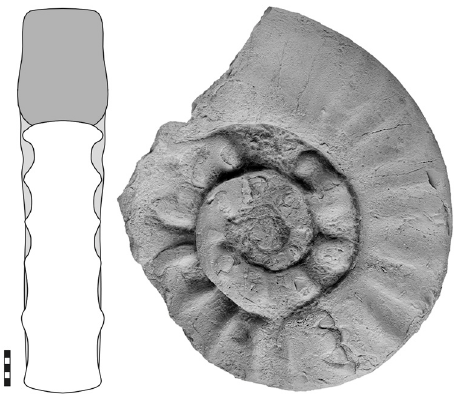
Fig. 18. Shevyrevites nodosus (Shevyrev, 1965), lateral and reconstructed dorsal view of specimen MB.C.29713. Scale bar units = 1